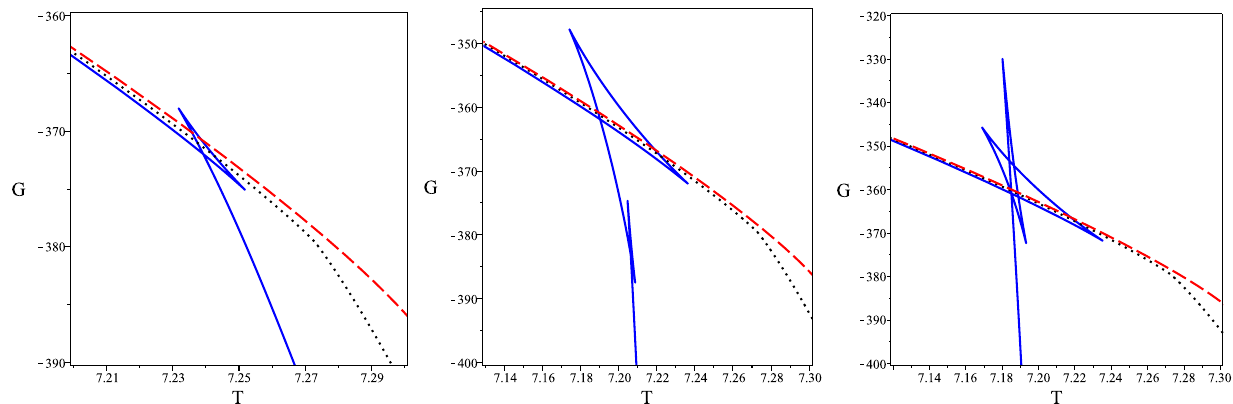
P (cid:5) P tr < P c Fig. 25 Analogue of triple point in spherical black holes: G − T dia- (continuous line), P = P c 2 grams; we have set k = 1, d = 7, q = 0, m (cid:5) 5 . 98, c 0 = 1, (dashed line). Critical data: ( P c c 1 (cid:5) − 3 . 98, c 2 (cid:5) 12 . 8, c 3 (cid:5) − 12 . 02, c 4 = 13 . 63 and α (cid:5) 9 . 08. < P < P = P Left panel: P c c 1 (continuous line), P c 1 (dotted line) 2 and P > P c ing behavior of the heat capacity near the triple point ( P tr ) is displayed (dashed line). Middle panel: P tr < P < P c (continuous 1 2 line), P = P c in Fig. 12 (dotted line) and P > P c (dashed line). Right panel: 1 1